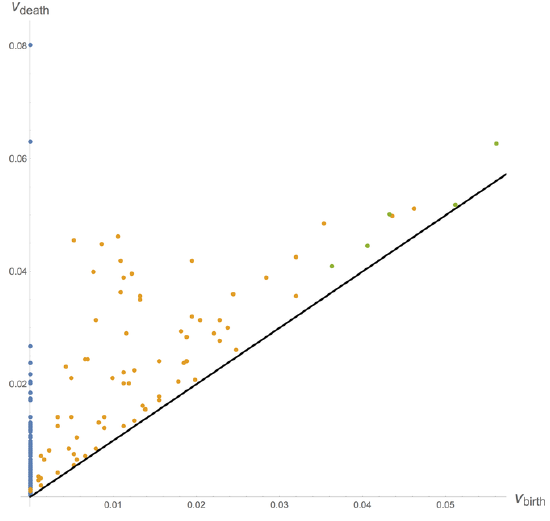
Figure 13 . Large-scale structure of W = 0 vacua for L max = 504. No higher-dimensional cycles live past the last disconnected component of the point